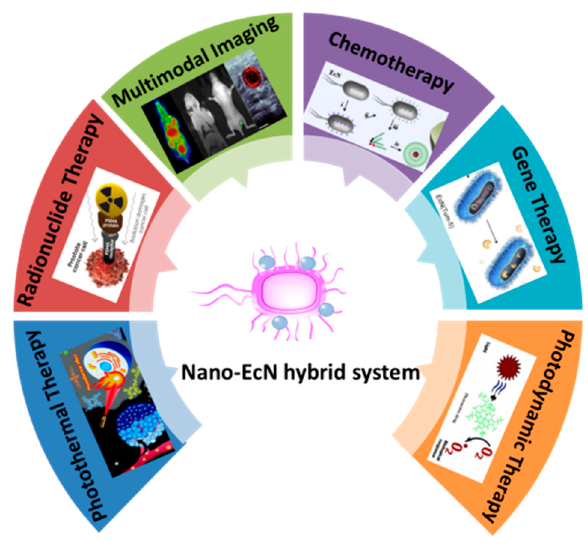
Figure 5. The future application of nano-bacteria hybrid